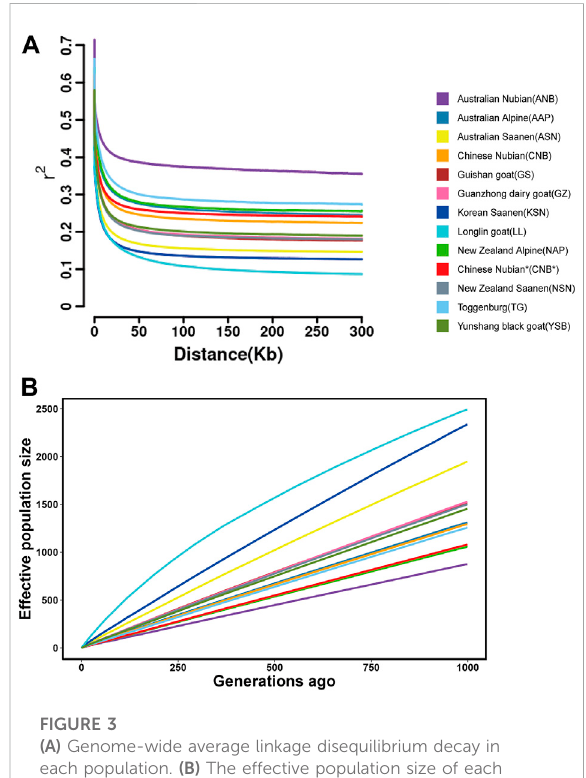
FIGURE 3 (A) Genome-wide average linkage disequilibrium decay in each population. (B) The effective population size of each population in recent 1,000 generations